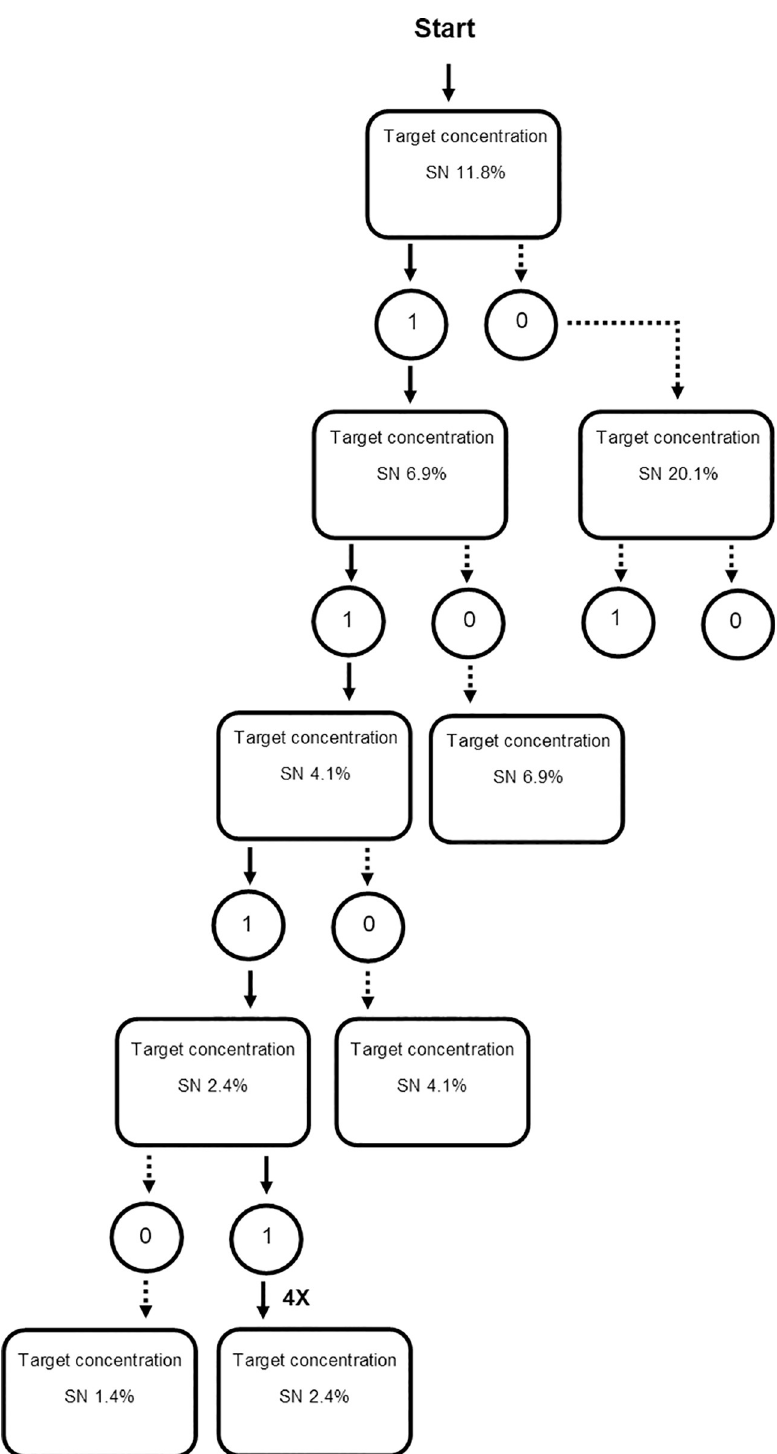
Fig 1. The test procedure (adapted from OCED Guideline 425) showing the process for the LOAEL/NOAEL determination for SN. This procedure uses very few animals. The acute toxicity study is a stepwise procedure, with the use of one animal per step. The acute toxicity of the test substance depends on the mortality and or moribund status of the animals, and 2–4 steps may be necessary for the evaluation. The starting dose (here 11.1% SN w/v) was tested once. If the animal died during the first test, this test was followed by testing a lower dose using a 1/1.7 progression factor. If